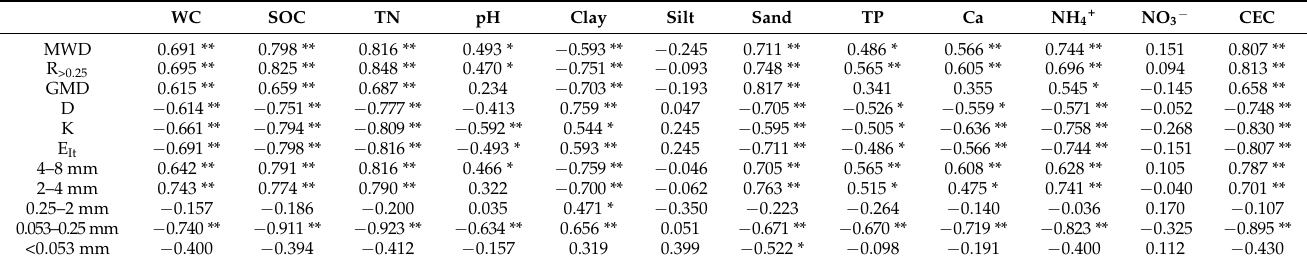
Table 3. Correlation between soil physicochemical properties and soil aggregate size distribution and stability.